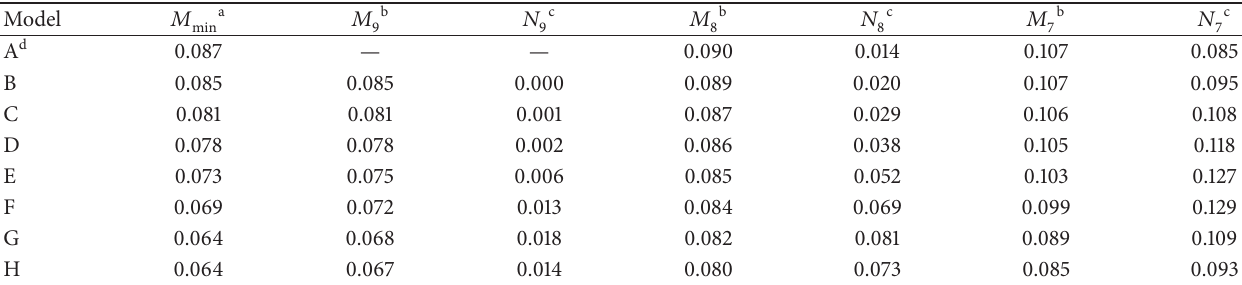
Table 2: Minimum mass and fractions of stars.